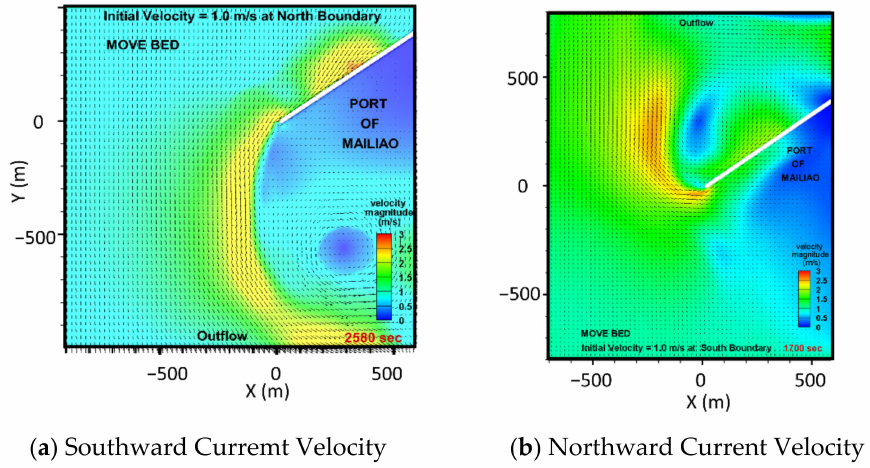
Figure 36. Depth-averaged flow velocity vector under the action of southward and northward